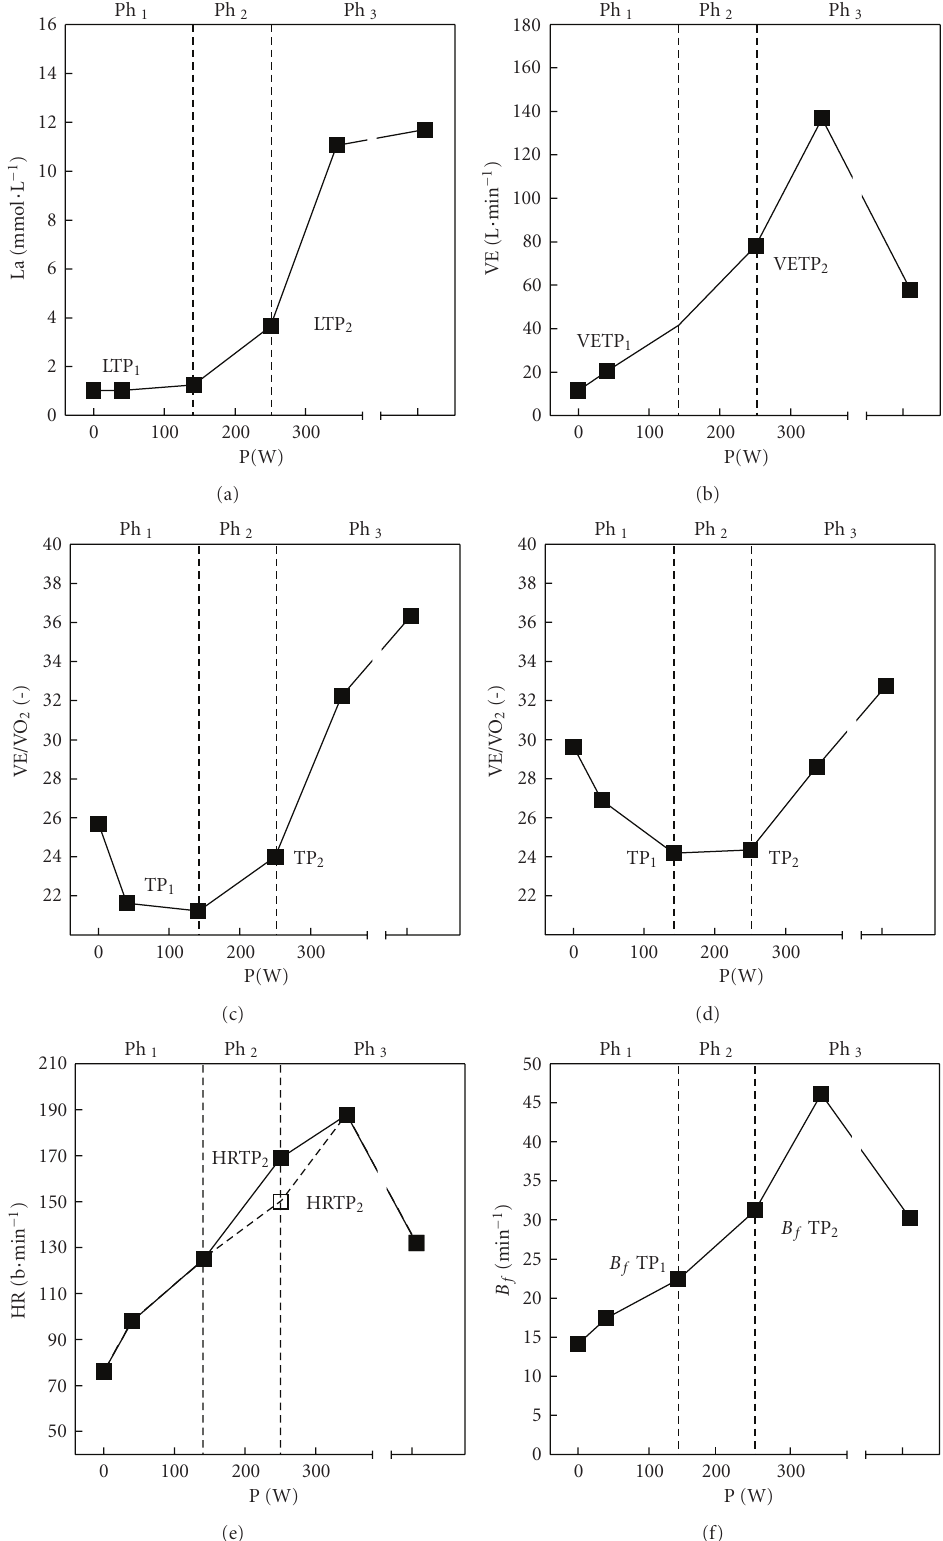
Figure 1: Schematic representation of first- and second- turn points of selected variables (La blood lactate concentration; VE: ventilation; VE/VO 2 : equivalent for oxygen uptake; VE/VCO 2 : equivalent for carbon dioxide output; HR: heart rate; B f : breathing frequency) and distinct phases (Ph 1–3) of energy supply determined from young healthy male subjects. Ph 1: no increase of blood lactate concentration above baseline during constant load exercise. Ph 2: increased but steady state blood lactate concentration during constant load exercise. Ph 3: continuous increase of blood lactate concentration during constant load exercise leading to early termination of